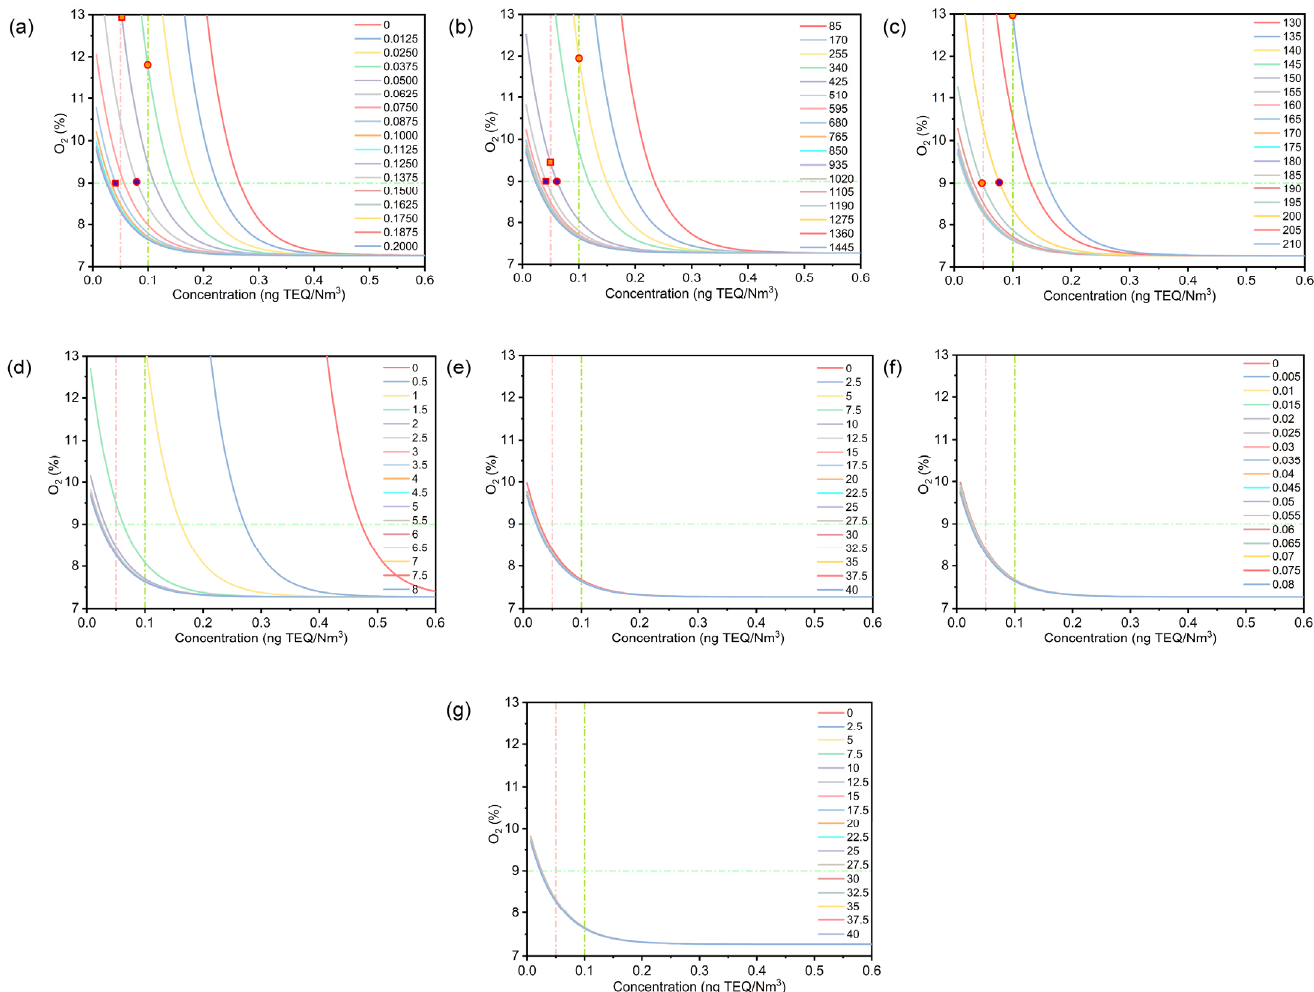
Figure 4. E ff ect of operating parameters on PCDD/F emissions through APCDs: ( a ) AC concentra- tion from 0.0500 g/Nm 3 to 0.2000 g/Nm 3 , ( b ) speci fi c surface area (SSA) of AC from 85 m 2 /g to 1445 m 2 /g, ( c ) operating temperature from 130 ° C to 210 ° C, ( d ) contact time from 0 s to 8 s, ( e ) fl y ash concentration from 0 g/Nm 3 to 40 g/Nm 3 , ( f ) residence carbon concentration in fl y ash from 0 to 0.08, and ( g ) lime concentration from 0 g/Nm 3 to 40 g/Nm 3 . In the fi gures ( a )–( g ), is the upper limit for 0.1 ng TEQ/Nm 3 , is the lower limit for 0.1 ng TEQ/Nm 3 , is the upper limit for 0.05 ng TEQ/Nm 3 , and is the lower limit for 0.05 ng TEQ/Nm 3 . The internationally authoritative meas- urement of SSA is usually measured by the low-temperature nitrogen adsorption method or static volumetric principle (static volumetric principle; V-Sorb 2800). The Brunauer–Emme tt –Teller (BET) theory is commonly used as the testing theory for SSA. In order to facilitate the understanding of more readers of the meaning of the picture more intuitively, in this manuscript, we replaced “SSA” with “BET”.